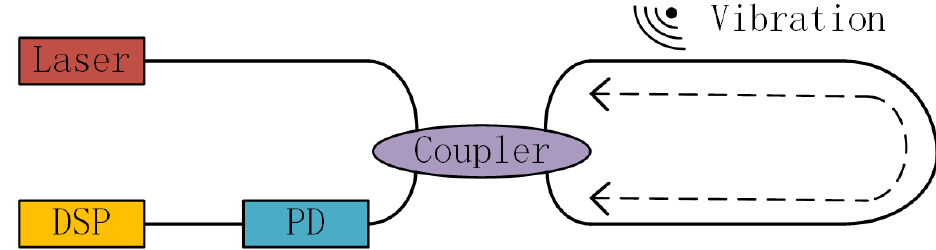
Figure 2. Working principle of Sagnac